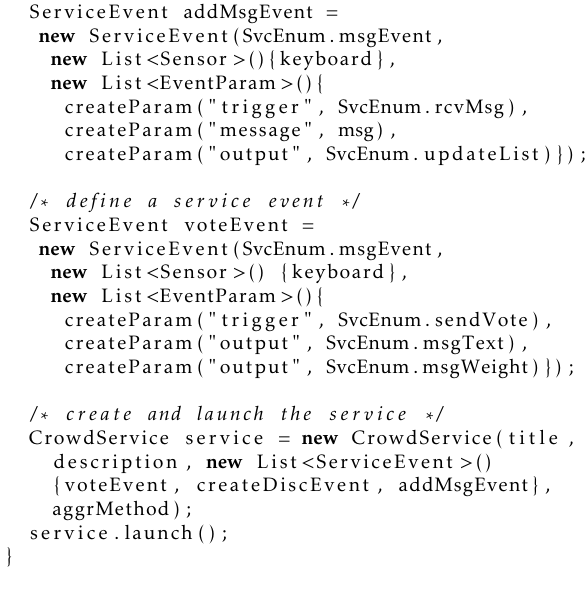
Figure 11. Twitter-like Messaging